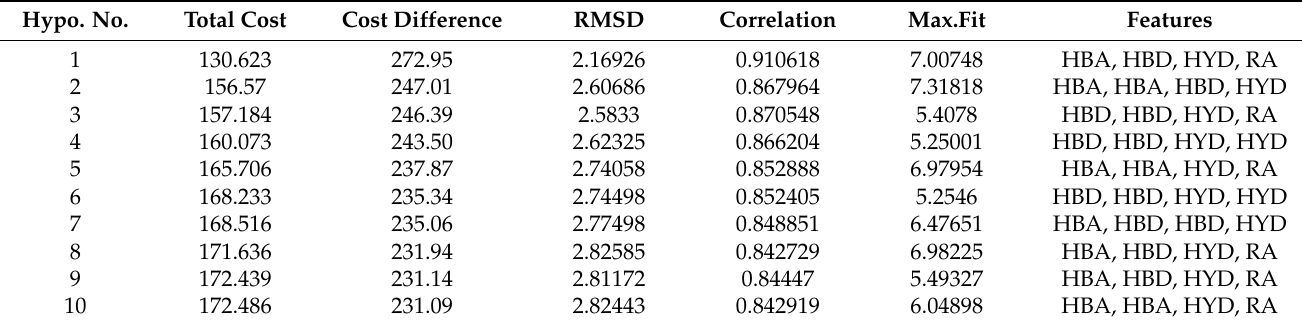
Table 1. Statistical results of the top 10 pharmacophore hypotheses generated by HypoGenalgorithm. Hypo. No.